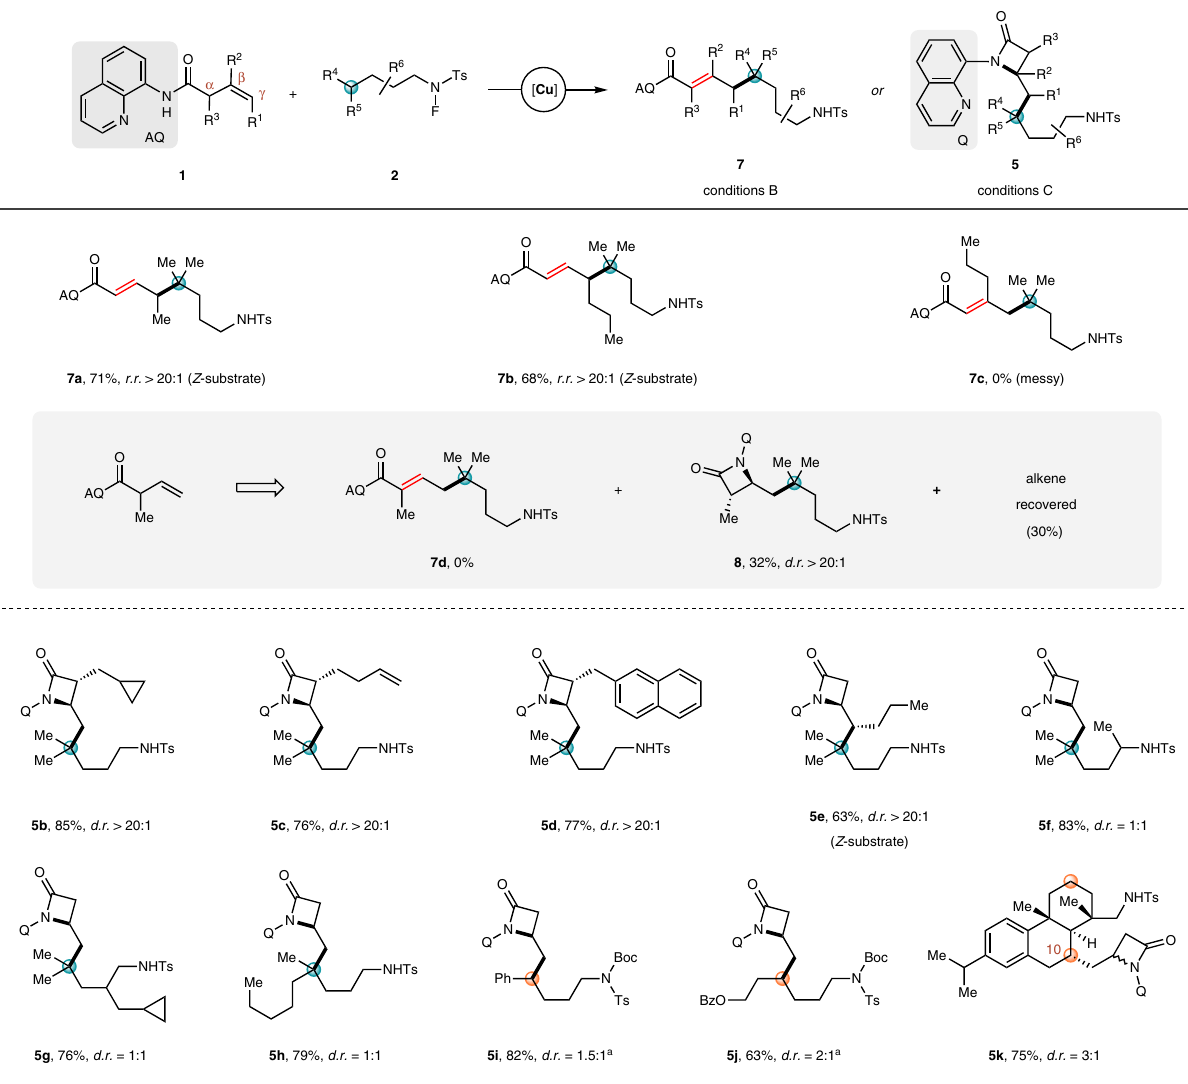
Fig. 6 | Substrate scope of alkenes for allylic coupling reactions and for the synthesis of β -lactams. Conditions B: 1 (0.20mmol), 2a (0.50mmol), Cu(T- FA) 2 ·H 2 O (0.02mmol), Zn(OAc) 2 (0.08mmol), and TFA (0.40mmol) in benzene (2.0mL) at 90°C for 4h. Conditions C: 1 (0.20mmol), 2a (0.50mmol), and